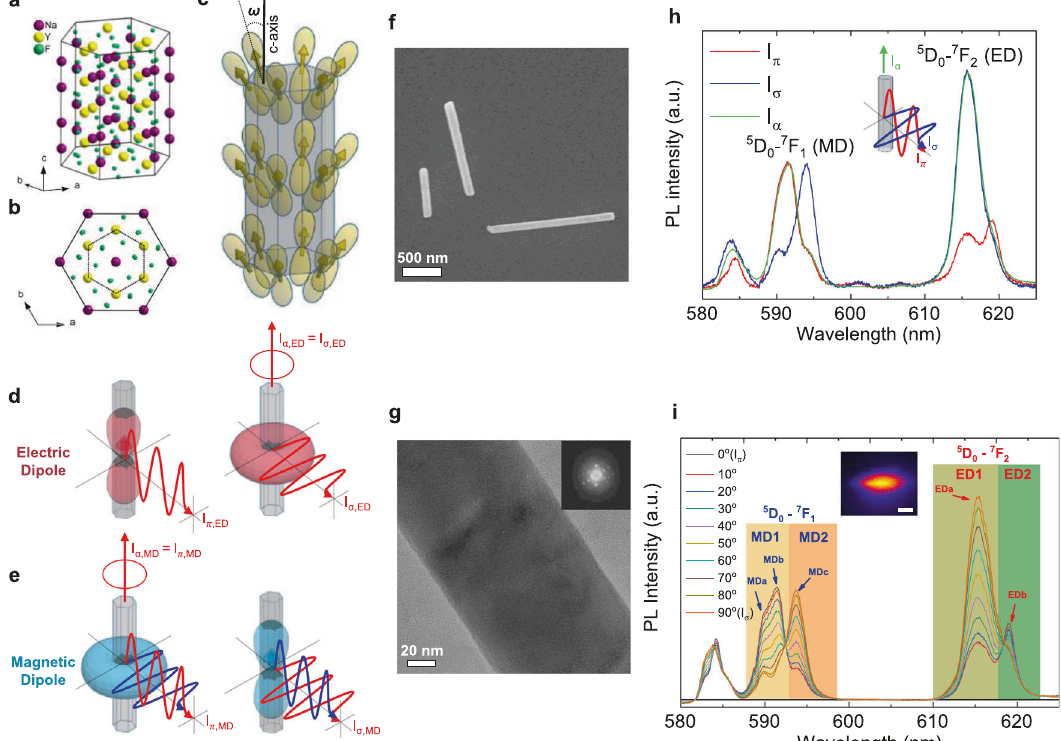
Fig. 2 Dipole con fi gurations and polarized spectra of the emission of Eu 3 + doped in NaYF 4 nanocrystal. a , b Illustrations of the hexagonal NaYF 4 crystallographic structure ( a ) in 3D perspective view and ( b ) projected on the basal plane. The Y 3 + sites are substituted when doped with Eu 3 + . c Schematic illustration of one kind of emission dipoles at the Eu 3 + sites oriented with a certain polar angle ( ω ) with respect to the c-axis. The site symmetry determines ω , and the crystal symmetry induces the hexagonal arrangement of the dipoles. d , e Schematic illustrations of the symmetric ensemble of ω - angled dipoles decomposed to two orthogonal components: a 1D dipole parallel to the c-axis and a 2D dipole parallel to the basal plane. d For electric dipole (ED), the 1D dipole contributes to the π -polarization and the 2D dipole contributes to the σ -polarization equal to the α -con fi guration. e This relation is inversed for magnetic dipole (MD) as its 1D dipole contributes to the σ -polarization and its 2D dipole contributes to the π -polarization equal to the α - con fi guration. f Scanning electron microscopy (SEM) image and ( g ) high-resolution transmission electron microscopy (HR-TEM) image with fast Fourier transformation (inset) of NaYF 4 :Eu nanorods. h Polarized photoluminescence (PL) spectra in π , σ , and α con fi gurations of NaYF 4 :Eu nanorods under the excitation at 394 nm ( 7 F 0 → 5 L 6 ). These spectra were obtained from a colloidal solution in which the nanorods were uniformly aligned by external electric fi eld (Supplementary Fig. 4). i Polarized PL spectra of a single NaYF 4 :Eu nanorod lying on a plane substrate with varied analyzer angles. The blue and red arrows indicate the three main peaks (MDa – c) in the 5 D 0 → 7 F 1 transition and the two main peaks (EDa – b) in the 5 D 0 → 7 F 2 transition. The selected wavelength ranges (MD1, MD2, ED1, and ED2) to perform the area under curve ratiometry are highlighted in different colors. The inset is an image of the nanorod obtained by scanning the PL signal using a piezo-stage (scale bar: 1 µ m). The full emission spectrum of NaYF 4 :Eu is shown in Supplementary Fig.